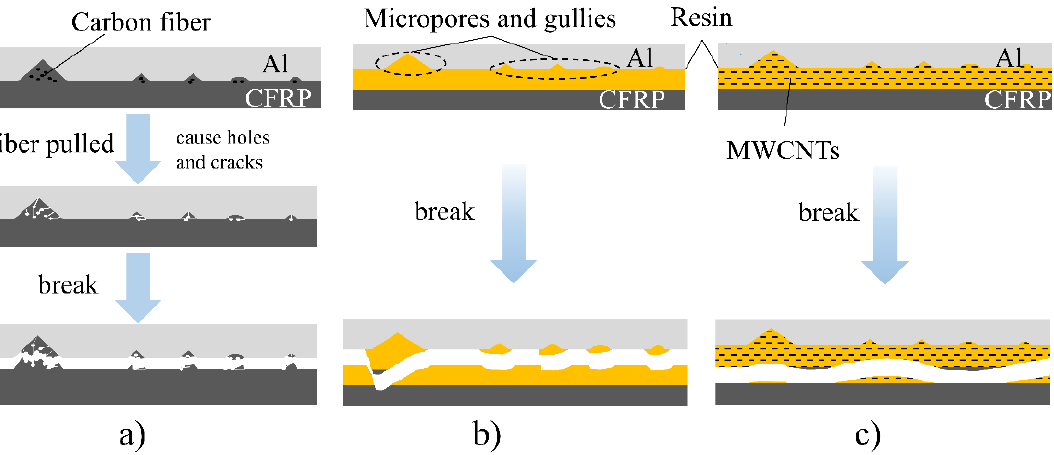
Figure 10. Schematic of shear failure between Al/CFRP layers after different interface treatments.